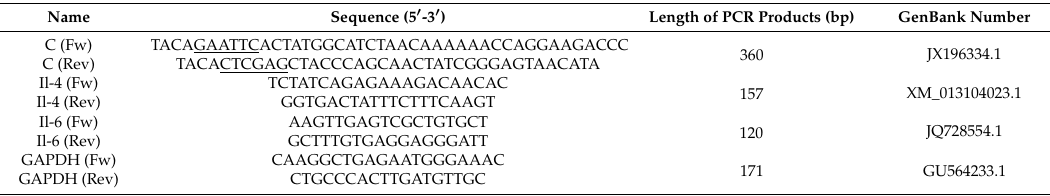
Table 1. Primers used in this